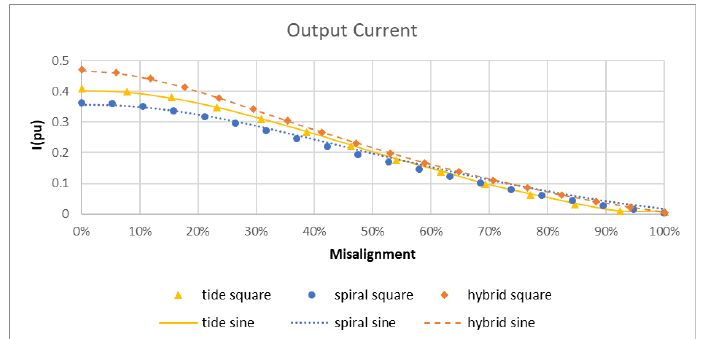
Figure 19. Measured output current for pure resistive load.